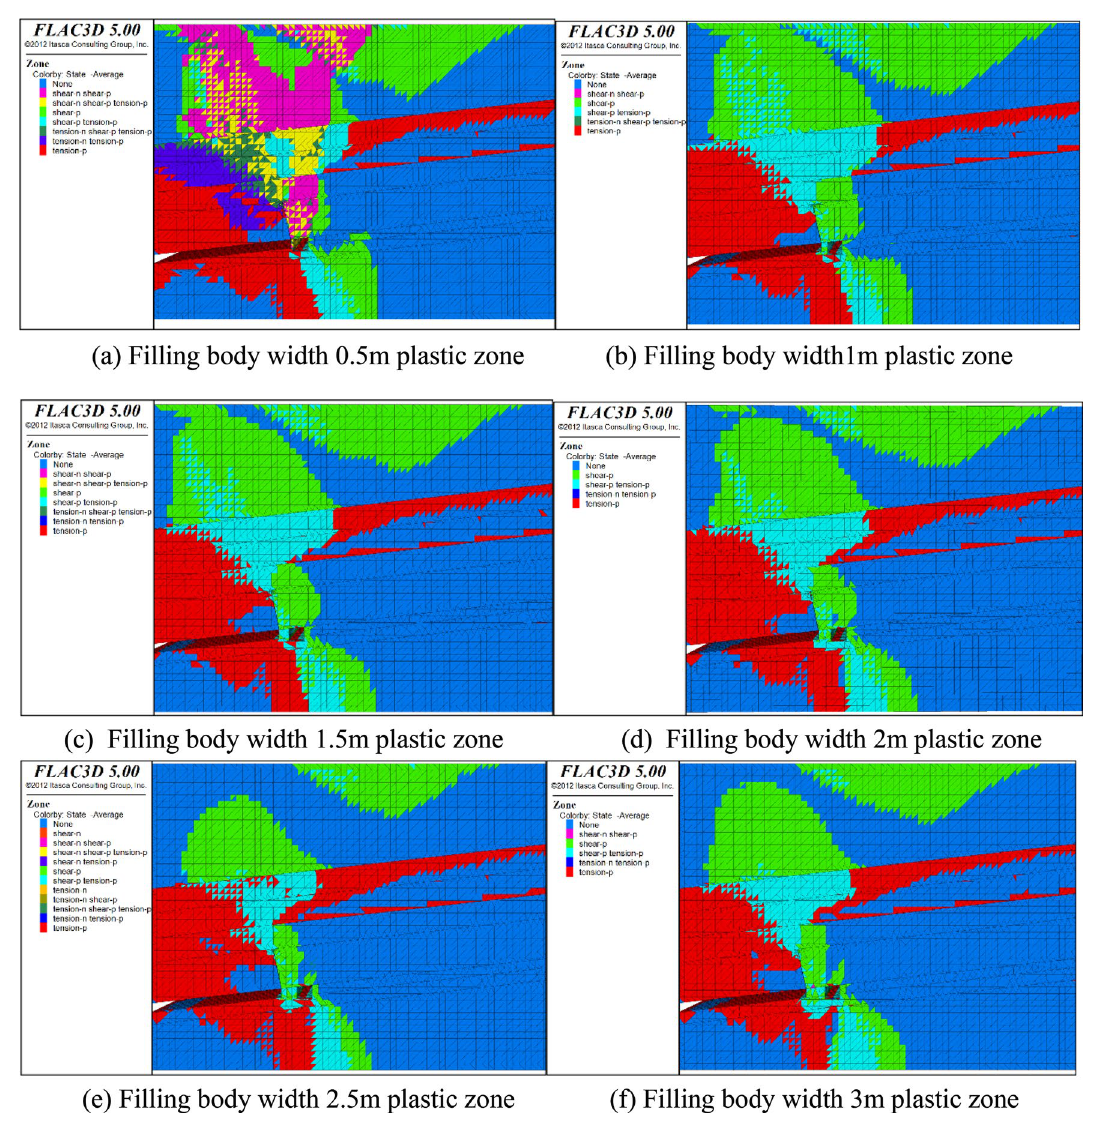
Figure 10. Distribution diagram of plastic distinction of different filling